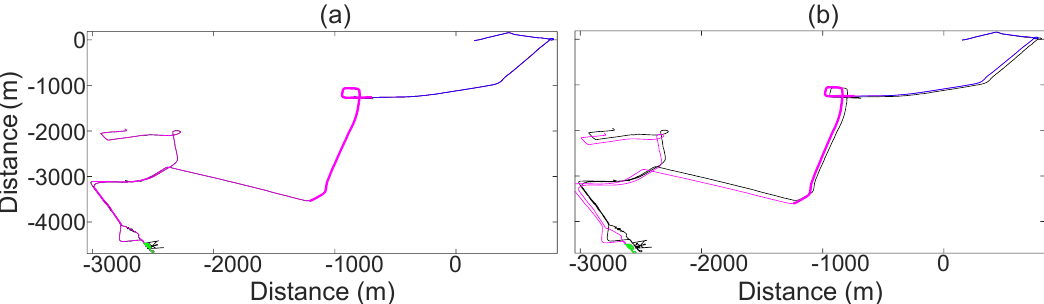
Figure 11. Shown is the vehicle position as measured by a SatNav receiver (black) and as estimated by means of statistical filtering (blue, magenta and green). ( a ) Shows the statistical filtering when SatNav correction data is used. ( b ) Shows the statistical filtering with no correction